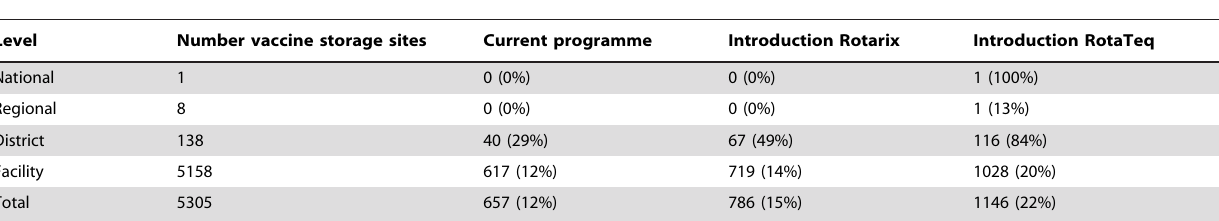
Table 5. Number of vaccine storage locations with an estimated shortage of more than 10% as estimated in CCEM for the current vaccination schedule, introduction of Rotarix (2 doses, volume 17.1 cm2 per dose), or introduction of RotaTeq (3 doses, volume 46.3 cm2 per